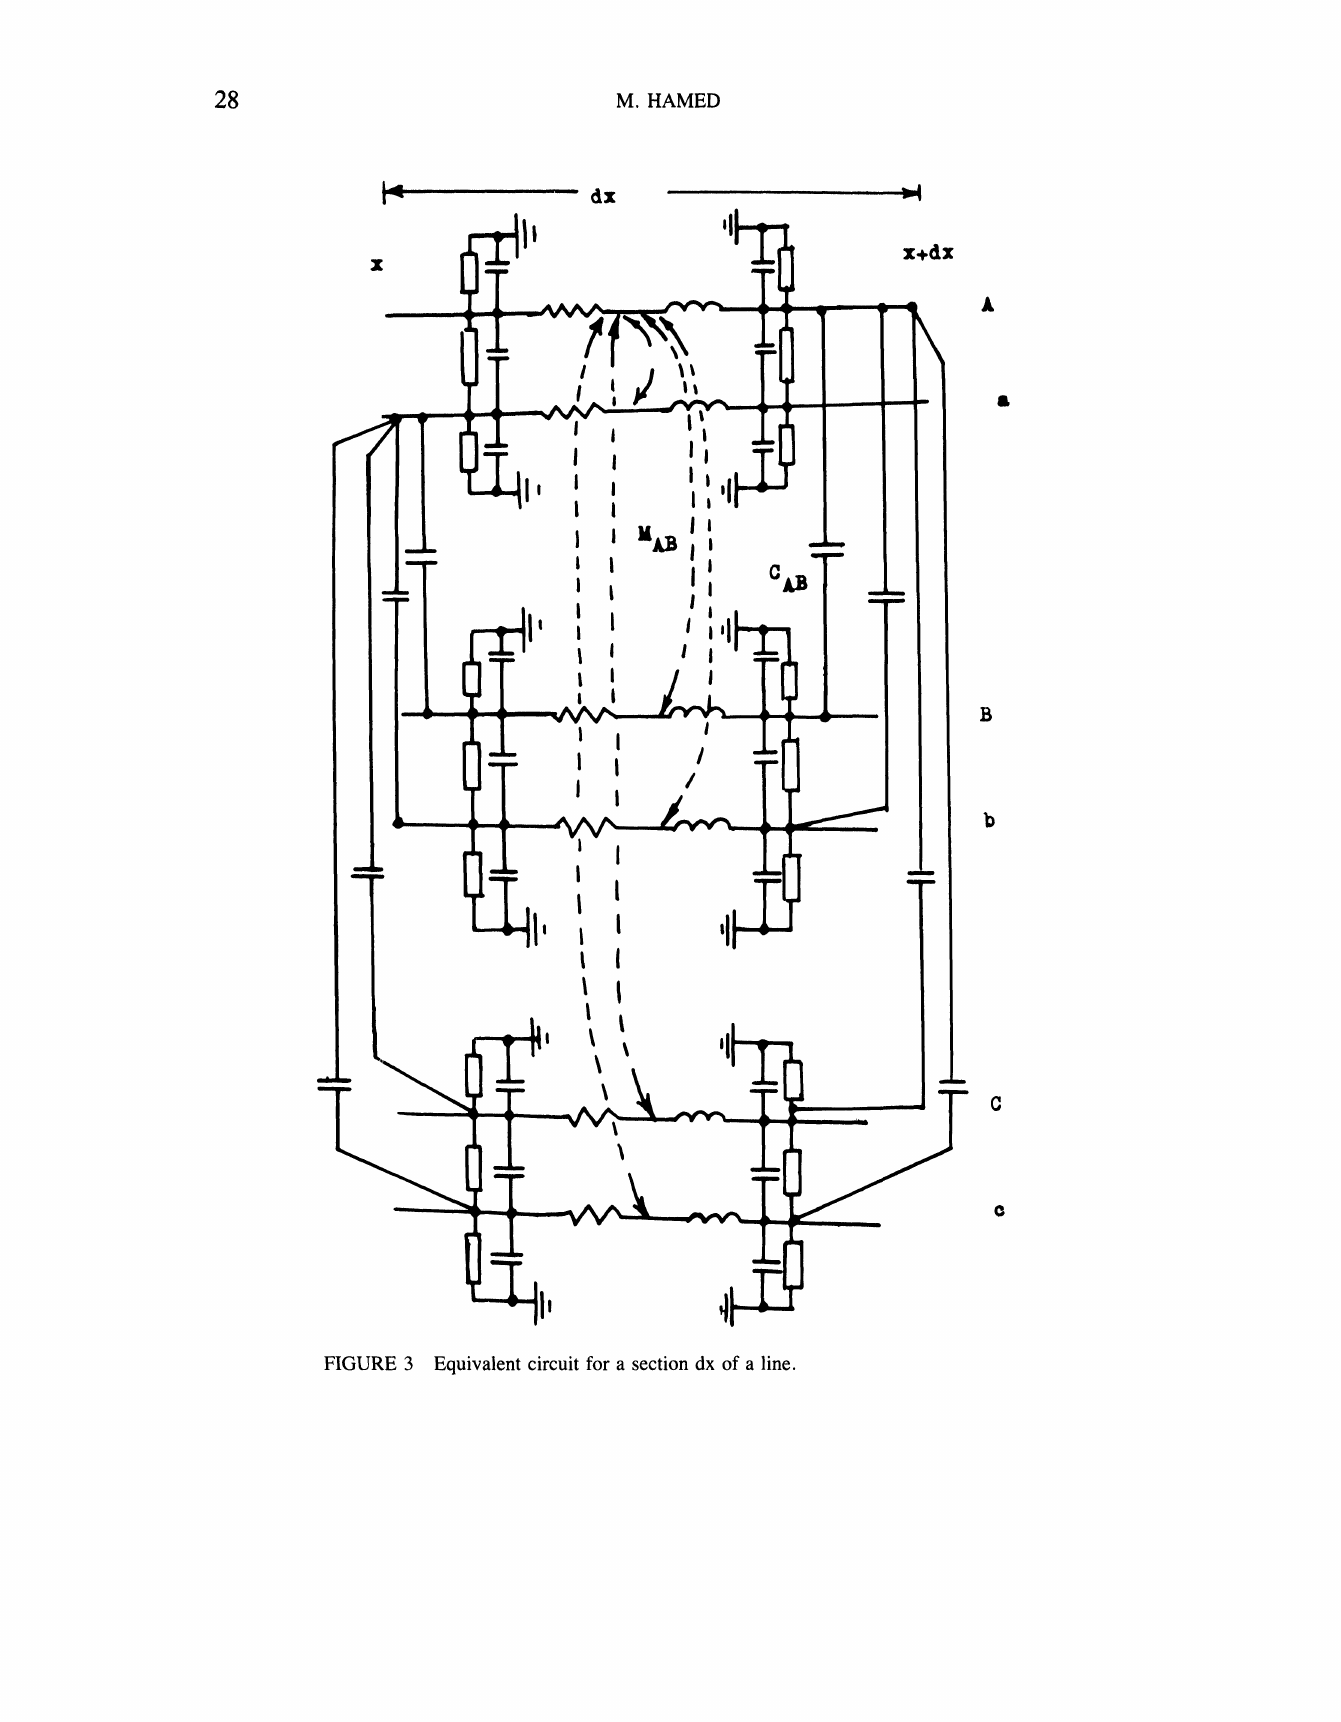
FIGURE 3 Equivalent circuit for a section dx of a